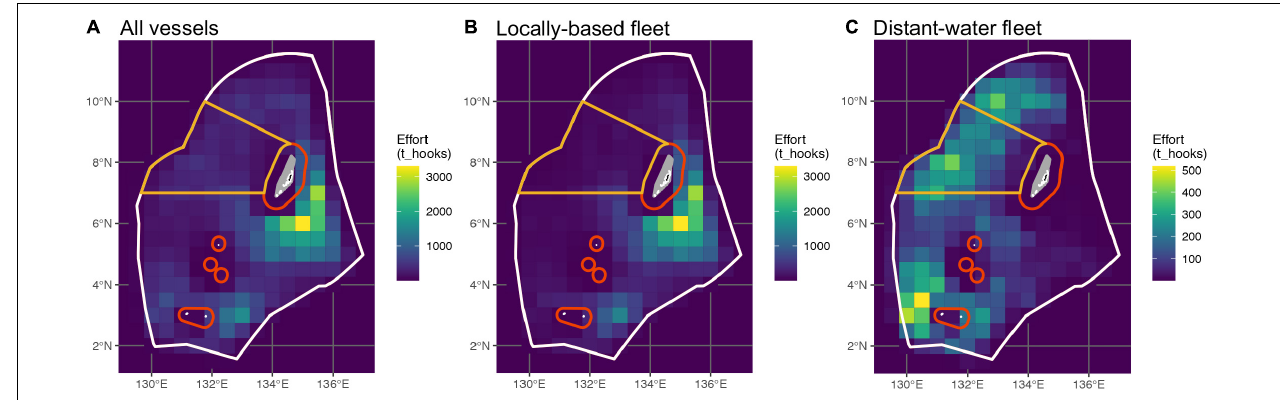
FIGURE 2 | Total fishing effort in Palau’s EEZ from 2010 to 2019, expended by panel (A) all vessels combined, (B) vessels of the locally based fleet (LBF), and (C) vessels of the distant-water fleet (DWF; note different effort scale). Colored lines denote the boundaries of the DFZ (orange) as it pertains to longline fishing, and the PNMS (red to white). Only local fishing for domestic consumption is permitted within the red 12 and 24 nm boundaries. Note that the DFZ and PNMS were implemented after the timeframe of this study; their boundaries are shown here to illustrate subsequent results and their discussion.